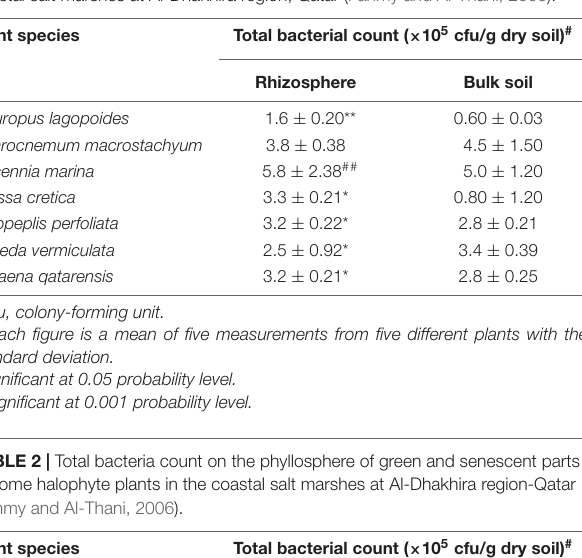
TABLE 1 | Total bacteria count in soil supporting halophytes growing in different coastal salt marshes at Al-Dhakhira region, Qatar (Fahmy and Al-Thani, 2006).